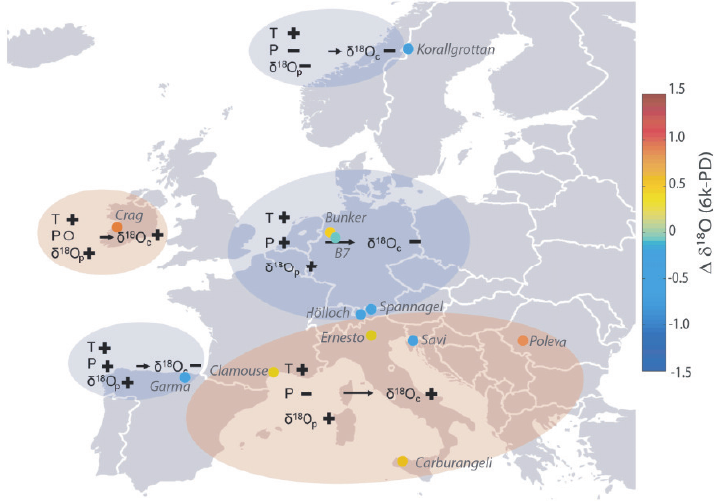
Fig. 8. Scheme illustrating the impact of the positive NAO mode on the European pattern of temperature, precipitation, δ 18 O prec and the resulting, hypothetical δ 18 O calcite as discussed in the text. “+” represents an increase, “ − ” represents a decrease and the circle represents invariance of the respective parameters. Coloured dots represent the measured 6ka δ 18 O calcite anomalies from the different